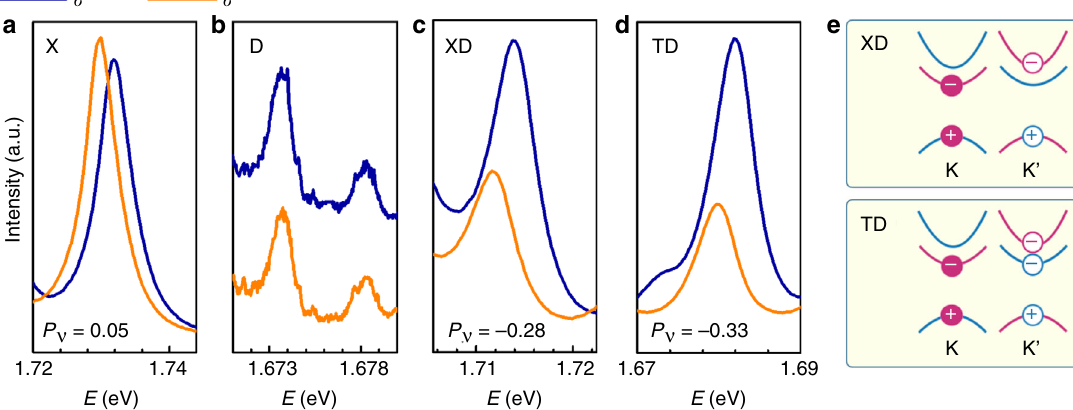
Fig. 5 The valley polarization of excitonic bound states in a fi nite out-of-plane magnetic fi eld. a – d The luminescence spectra of X, D, XD, and TD emission in σ + and σ − channels at 8 Tesla. Valley polarization is de fi ned as P and TD bound